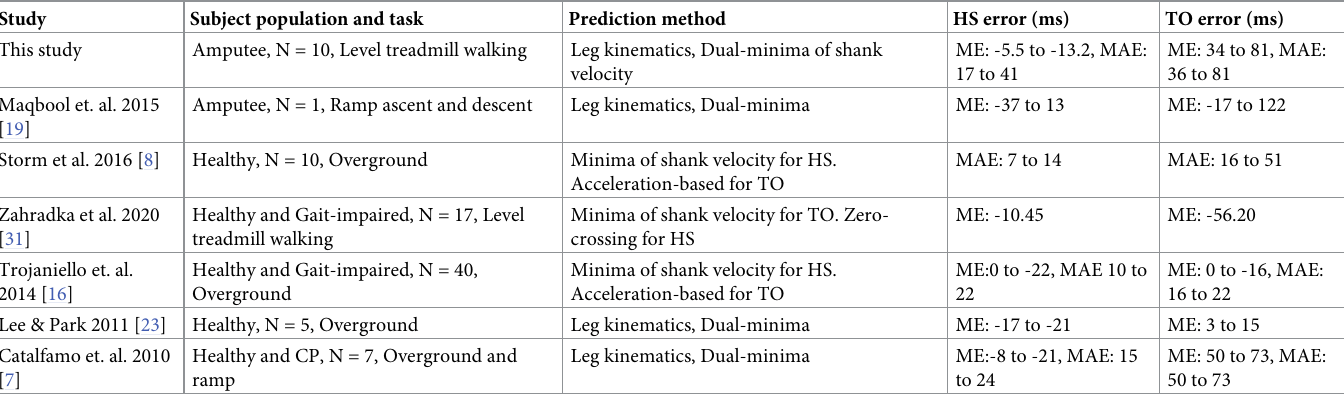
velocity Acceleration-based for TO Minima of shank velocity for TO. Zero- crossing for HS Minima of shank velocity for HS. Acceleration-based for TO